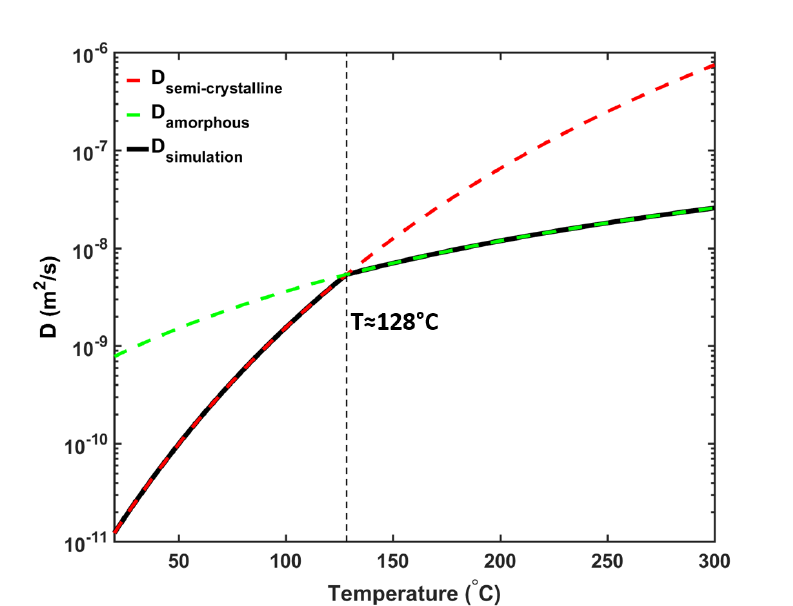
Figure 5. CH 4 diffusion coefficient variations in XLPE as semi-crystalline [13] (red line) and amorphous [35] (green line) phases of the XLPE, which were then combined to represent the diffusion coefficient variation applied in the simulation (black